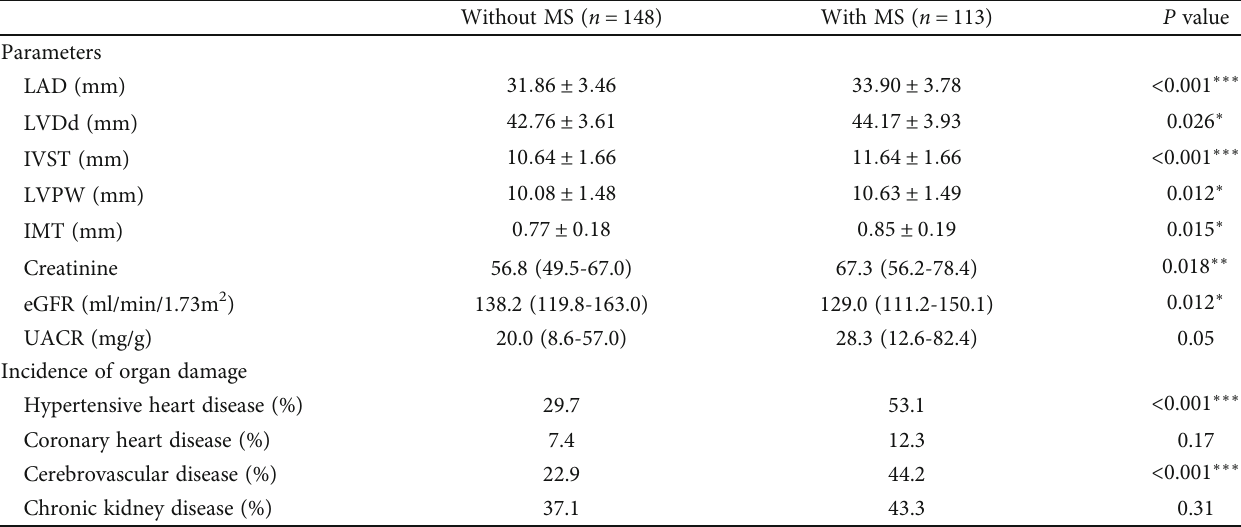
Table 2: Target organ damage in PA patients with or without